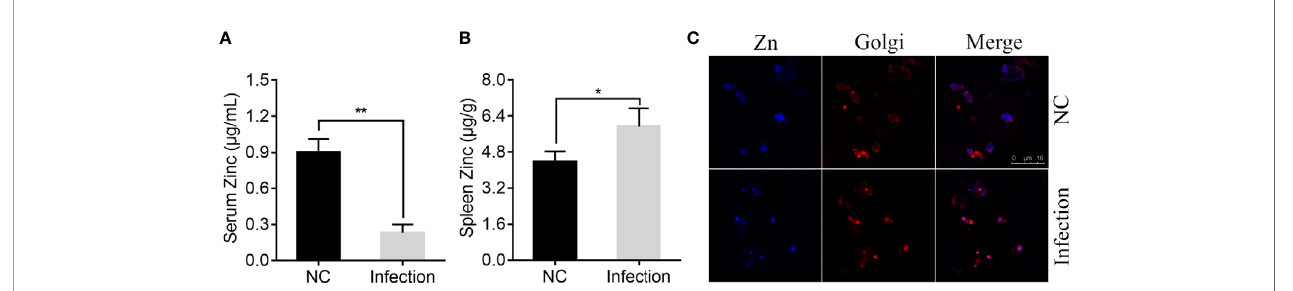
FIGURE 1 | Effect of Pseudomonas plecoglossicida infection on Zinc (Zn) concentration in serum, spleen, and macrophages. (A) Serum Zn concentrations and (B) spleen Zn concentrations were measured via inductively coupled plasma mass spectrometry (ICP-MS) in Epinephelus coioides infected with P. plecoglossicida at 48 hpi and compared to the healthy E. coioides . Values are mean ± SD (n = 3, * P < 0.05, ** P < 0.01). (C) Confocal microscopy was used to visualize labile Zn with the fl uorescent probe, Zinquin ethyl ester. Staining for Zn (blue) and Golgi (red) in macrophages. Purple shows a co-localization of Golgi and Zn. Scale bars represent 10 m m, 3 independent